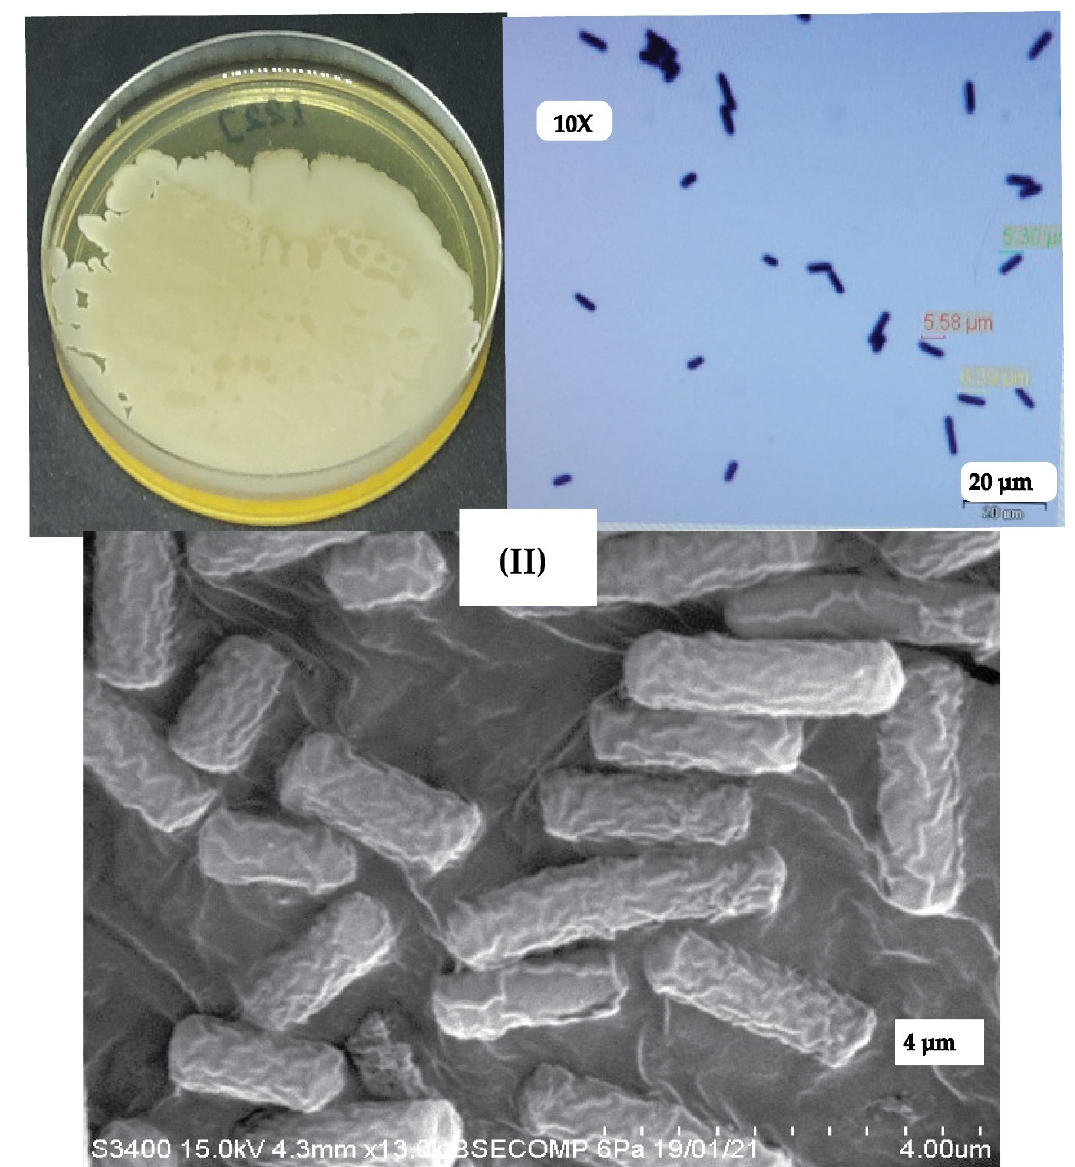
Figure 3. Physical characteristics of colony morphology, Gram staining (under stereo and light microscope), and SEM view of the APPB isolates on nutrient agar: ( I ) APPB1 and ( II ) APPB2.